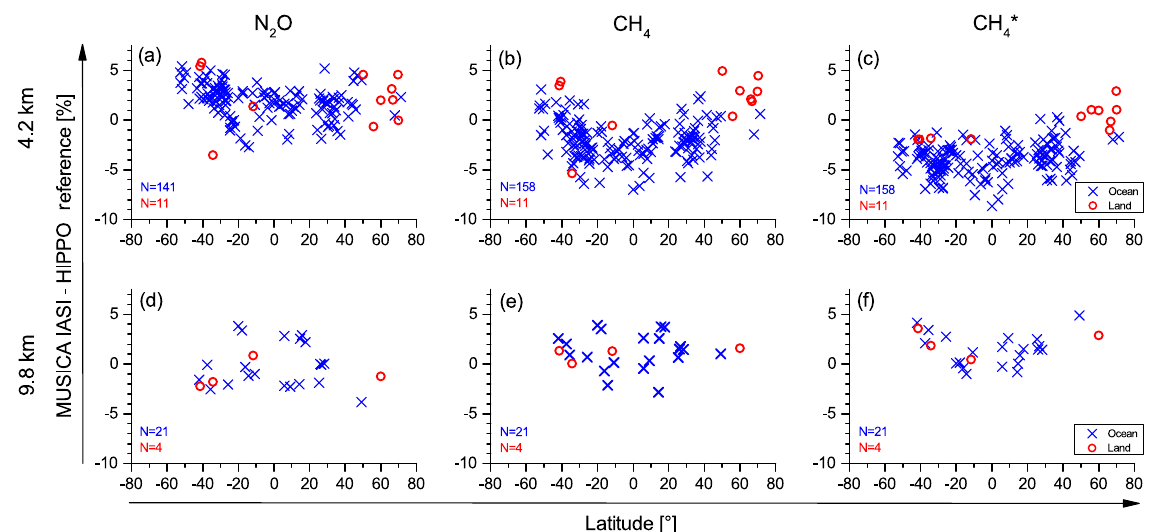
Figure 9. Latitudinal dependence of the difference between MUSICA IASI products and HIPPO data: (a–c) for the altitude of 4.2kma.s.l.; (d–f) for the altitude of 9.8kma.s.l.; (a) and (d) for N 2 O; (b) and (e) for CH 4 ; and (c) and (f) for CH ∗ IASI observations over ocean and land,